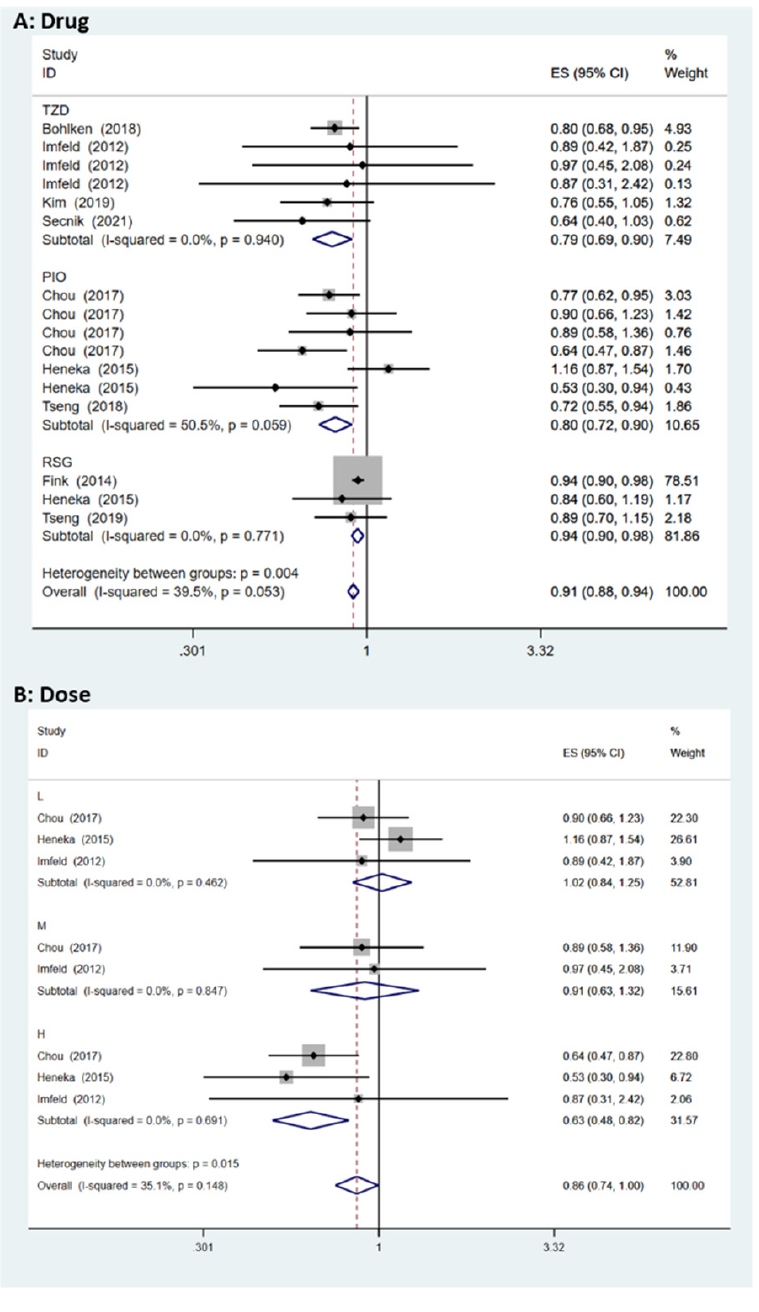
Figure 2. Dementia risk under PPAR- γ agonist treatment in DM patients (sub-group: Figure 2A drug, Figure 2B drug dose).